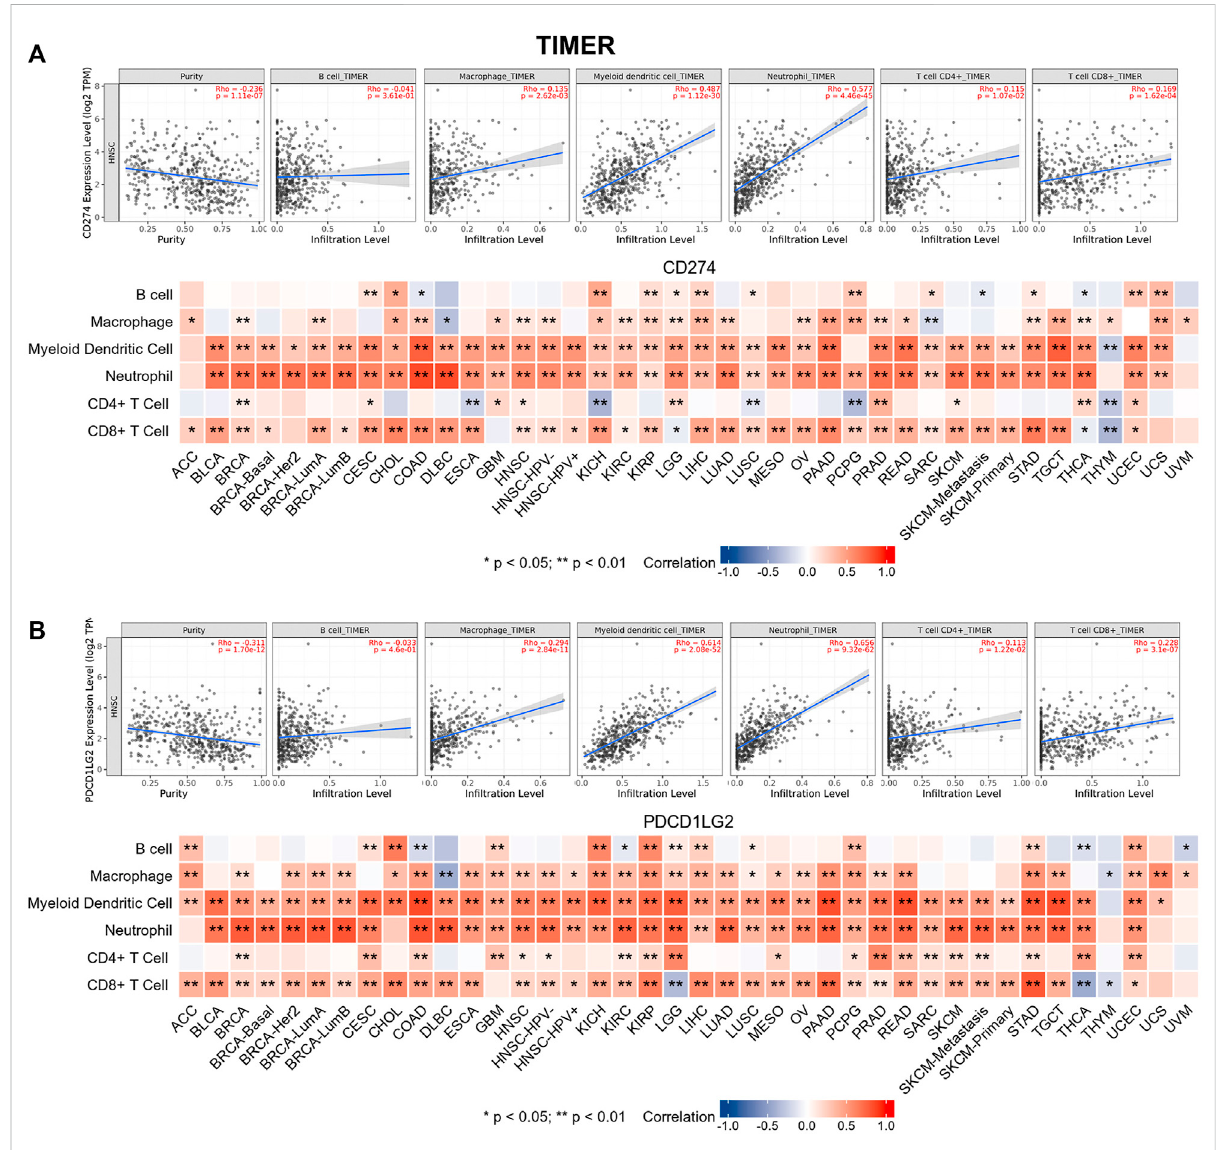
FIGURE 5 Relationships between (A) CD274 and (B) PDCD1LG2 expression and six types of immune cells across cancers determined using TIMER. Representative results in HNSC are shown at the